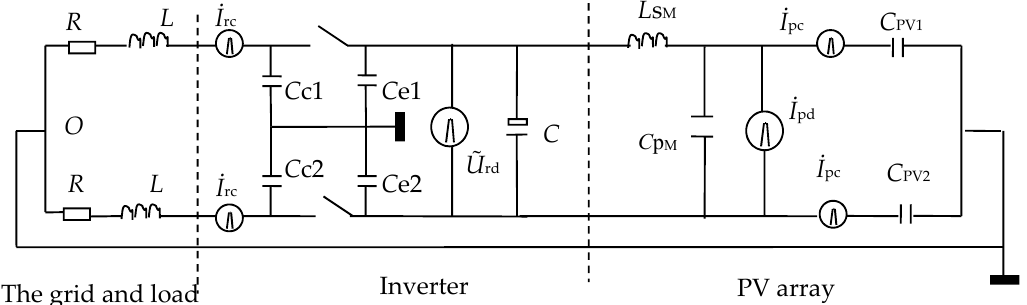
Figure 5. Noise interference model of the inverter and PV array.